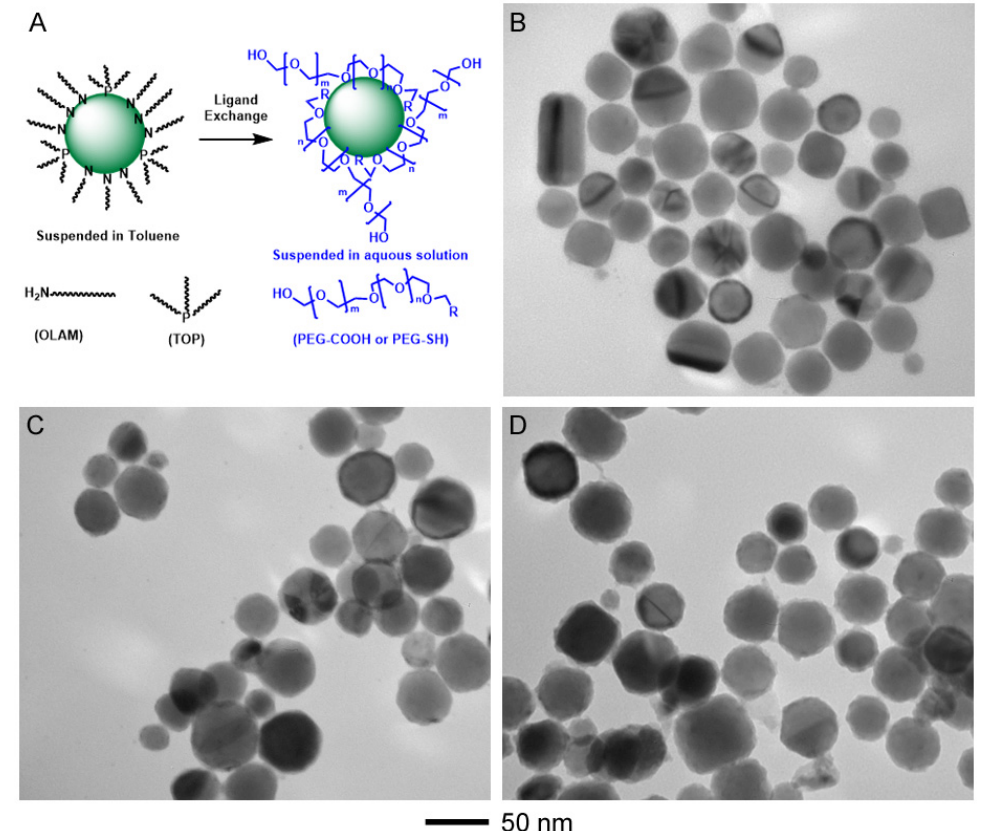
Figure 1. ( A ) Schematic illustration of the ligand exchange reaction where the OLAM/TOP ligands on CuNPs were replaced by PEG-COOH or PEG-SH. ( B–D ) TEM images of OLAM/TOP coated CuNPs ( B ); PEG-COOH coated CuNPs ( C ); and PEG-SH coated CuNPs ( D ).